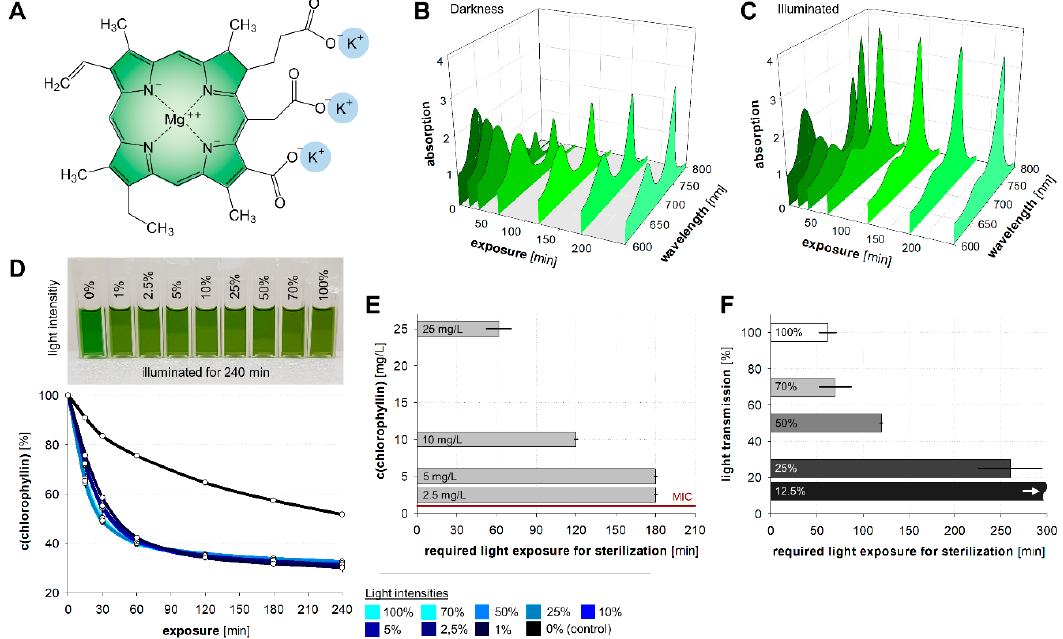
Figure 6. ( A ) Chemical structure of isolated chlorophyllin. ( B ) Alterations of chlorophyllin’s absorption spectrum in darkness and ( C ) exposed to light with 12 mW/cm 2 . ( D ) Reduction of chlorophyllin concentration exposed to different light intensities. ( E ) Required light exposure times to sterilize an E. coli DH5 α suspension culture initial cell number: ~10 6 cfu/mL) with a light intensity of 12 mW/cm 2 using different chlorophyllin concentrations. ( F ) Required light exposure times to sterilize an E. coli DH5 α suspension culture (initial cell number: ~10 6 cfu/mL) with a chlorophyllin concentration of 25 mg/L and different light intensities. For 12.5% light intensity no sterilization was observed within 300 min. Depicted are means ± standard deviation.